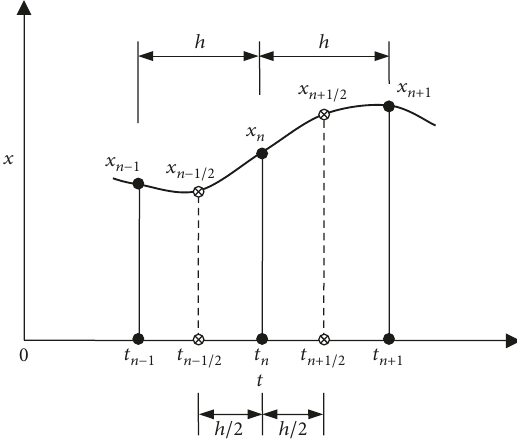
Figure 5: Central difference